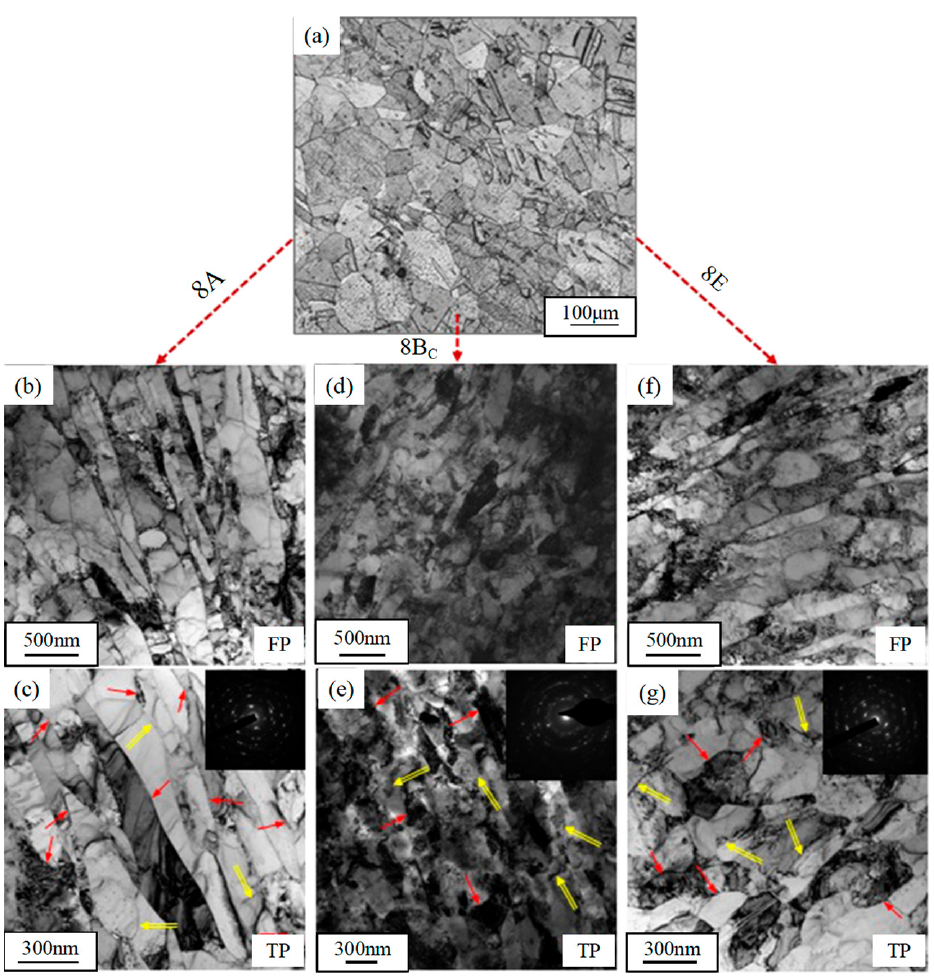
Figure 11. TEM images of the microstructure of Cu Alloys after eight passes of ECAP [73]: ( a ) is the pre-ECAP microstructure; ( b , c ) is the lateral and flow surface of the A route; ( d , e ) is the lateral and flow surface of the B C route; ( f , g ) are the lateral and flow surface of the E route. Reproduced with permission from Elsevier B.V.